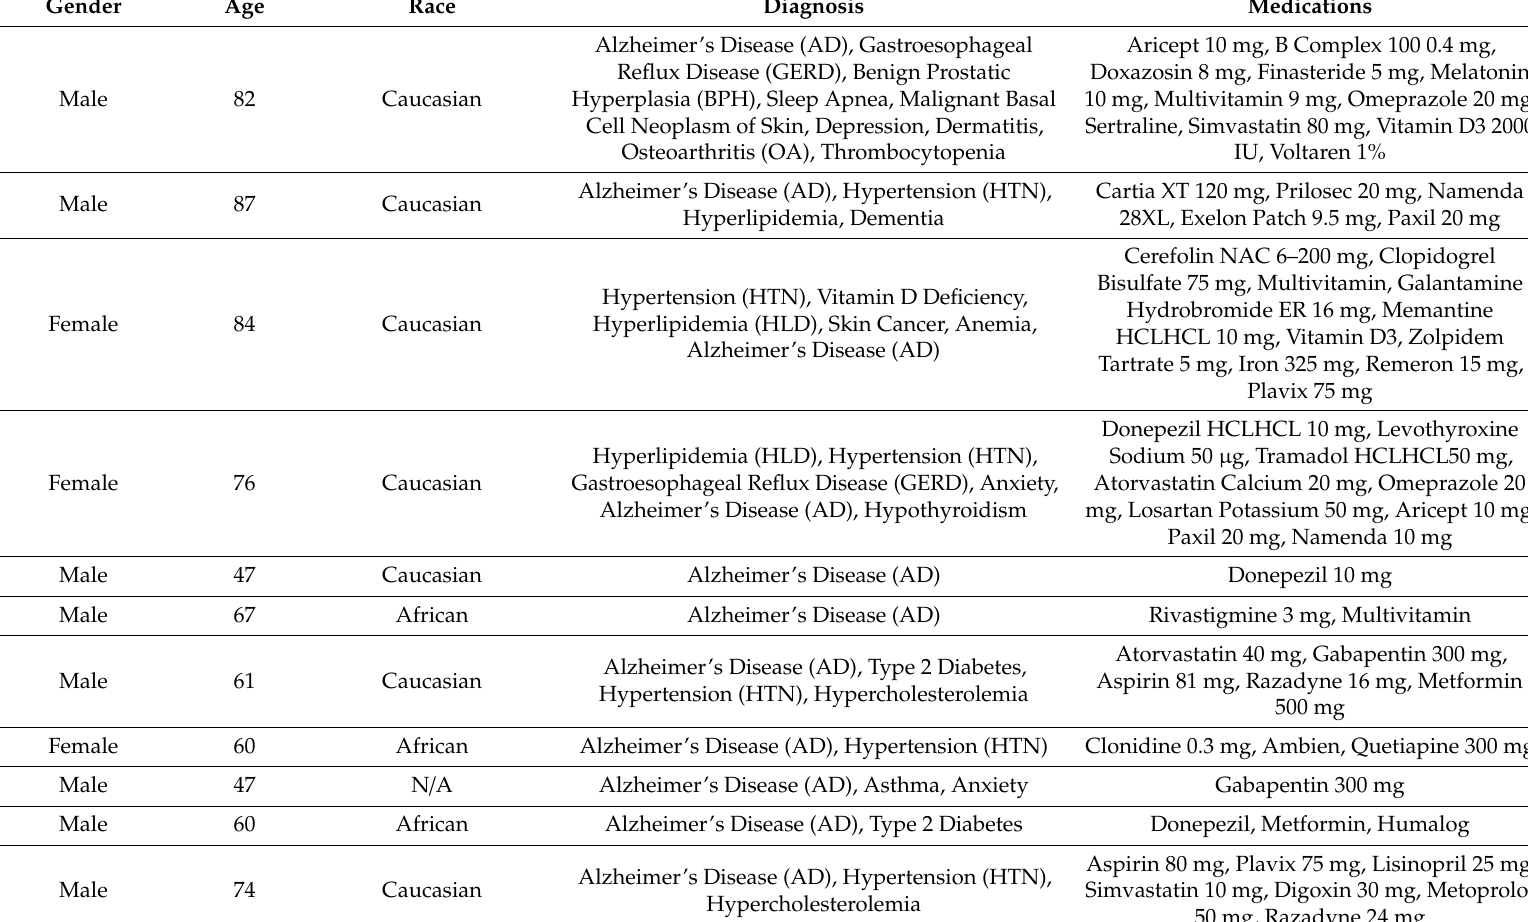
Table 4. Patients with AD used in this